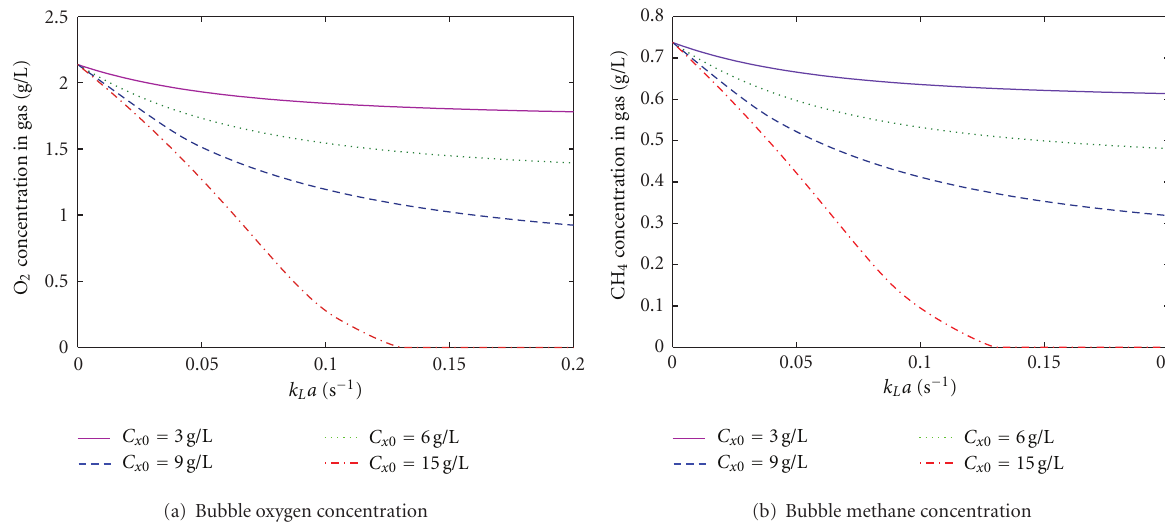
Figure 6: E ff ect of the volumetric mass transfer coe ffi cient on the concentration of oxygen and methane in the gas phase exiting the reactor ( P T = 3atm, G/L = 0.20, and U L = 0 . 5